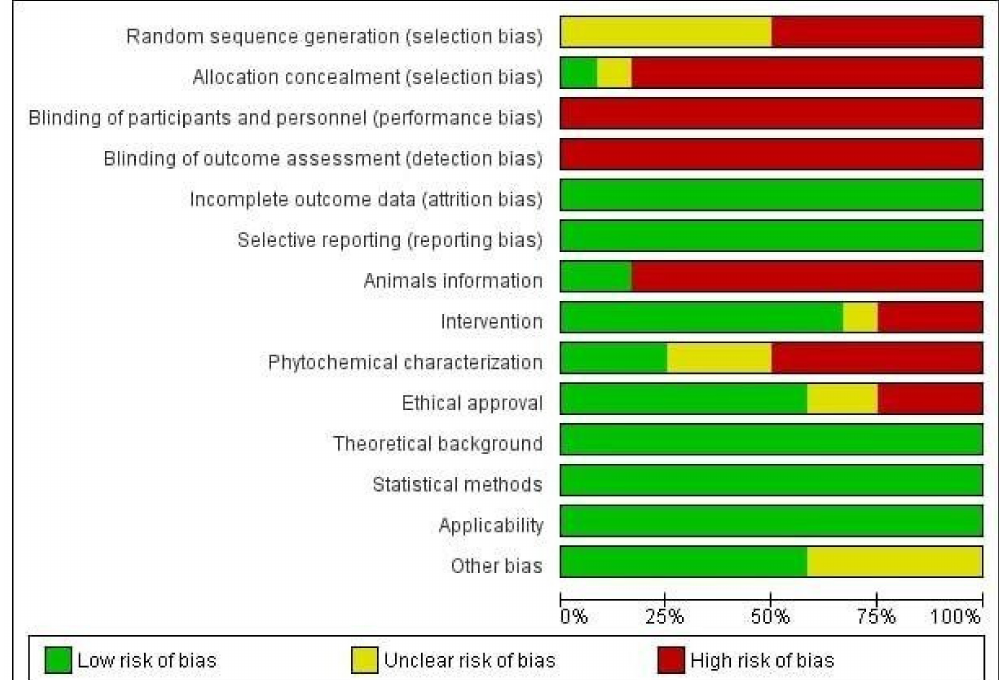
Figure 3. Results for the risk of bias and methodological quality indicators for all in vivo studies included in this systematic review that evaluated the effects of the Brassicaceae family on skin changes. The items in the Systematic Review Centre for Laboratory animal Experimentation (SYRCLE) Risk of Bias assessment were scored with “yes”, indicating low risk of bias (green), “no”, indicating high risk of bias (red), or “unclear”, indicating that the item was not reported, resulting in an unknown risk of bias